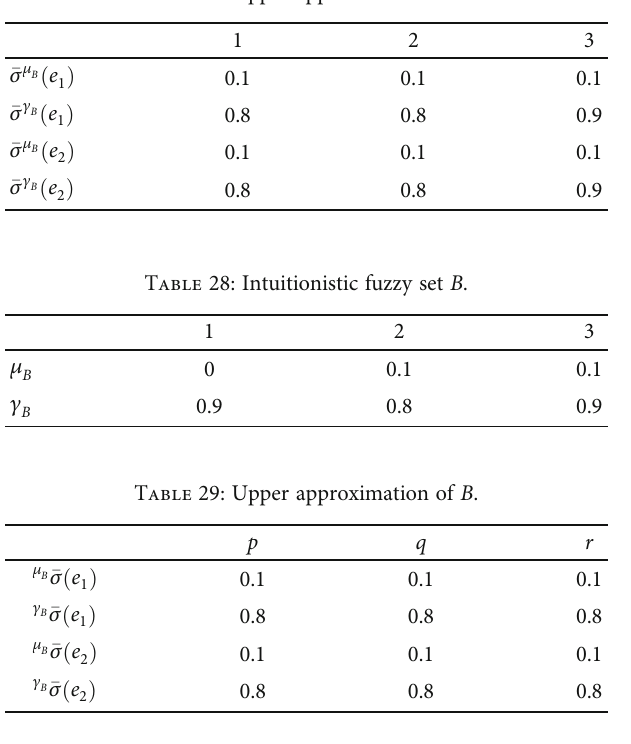
Table 30: Intuitionistic fuzzy set B